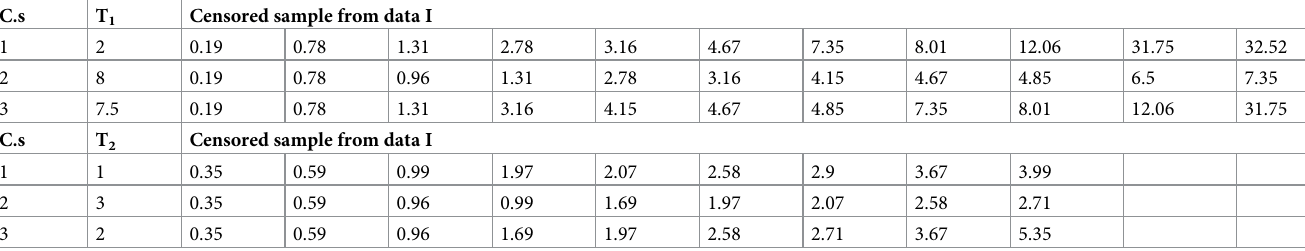
Table 12. Adaptive type-II censored samples form data I and data